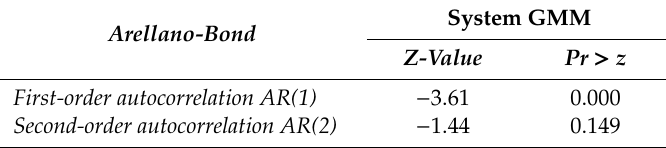
Table 3. Arellano–Bond Test for the pecking order